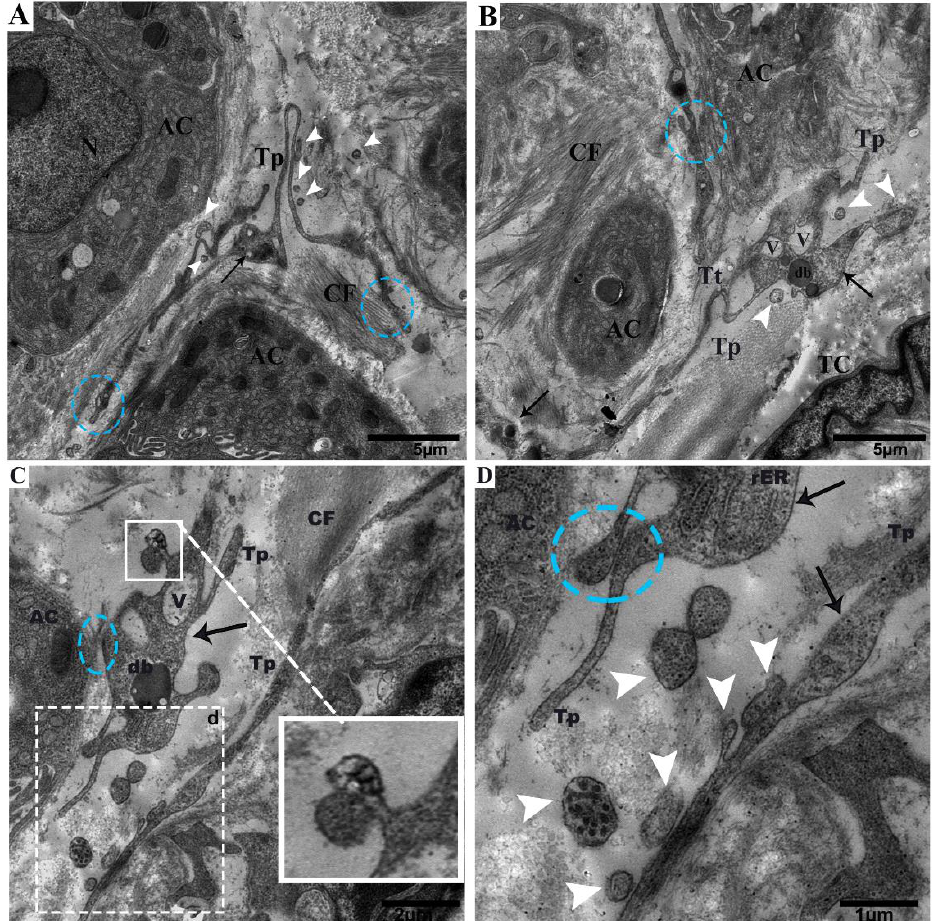
droplet; AC, acinus; CF, collagen fibers; V, vesicle. Scale bar = 2 µm in ( A ); scale bar = 1 µm in ( B – E ).